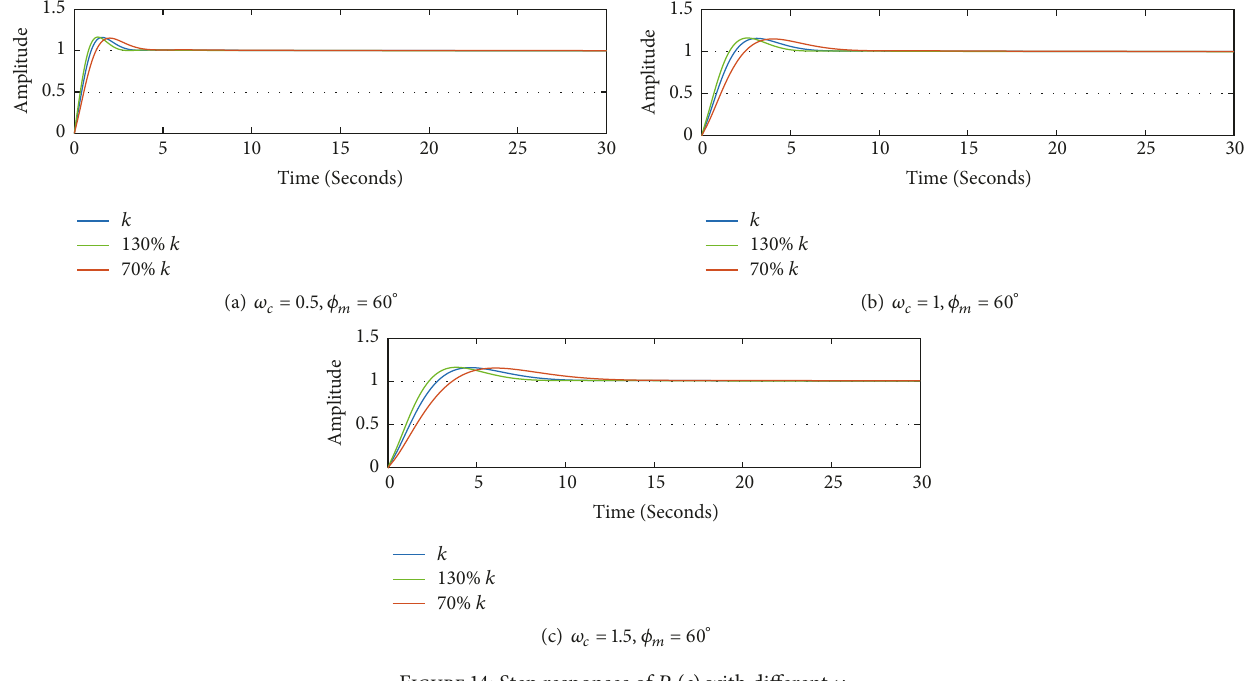
Figure 14: Step responses of 𝑃 1 (𝑠) with different 𝜔 𝑐